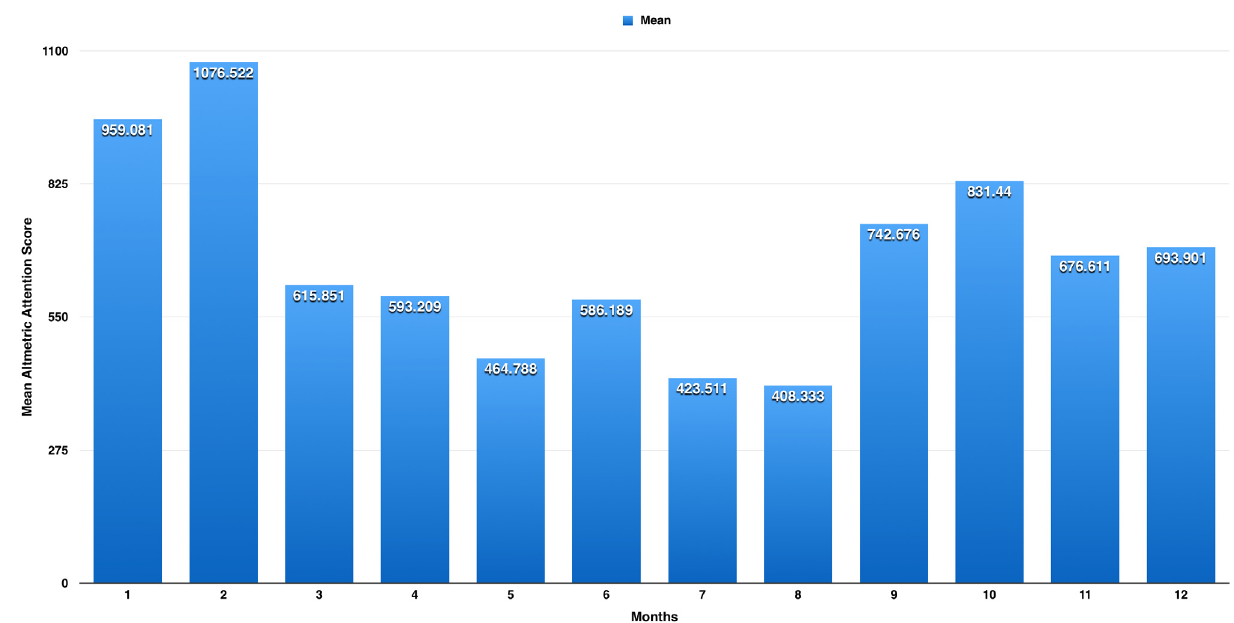
Figure 1. Average Altmetric Attention Score (AAS) for each month from years 2012 to 2018. There are three peaks for the AAS; the highest is observed in February with a mean AAS of 1076.5 (±614.6), the second peak is in October with a mean AAS of 831.4 (±441.9), and the third is in June with a mean AAS of 586.2 (±271.1).